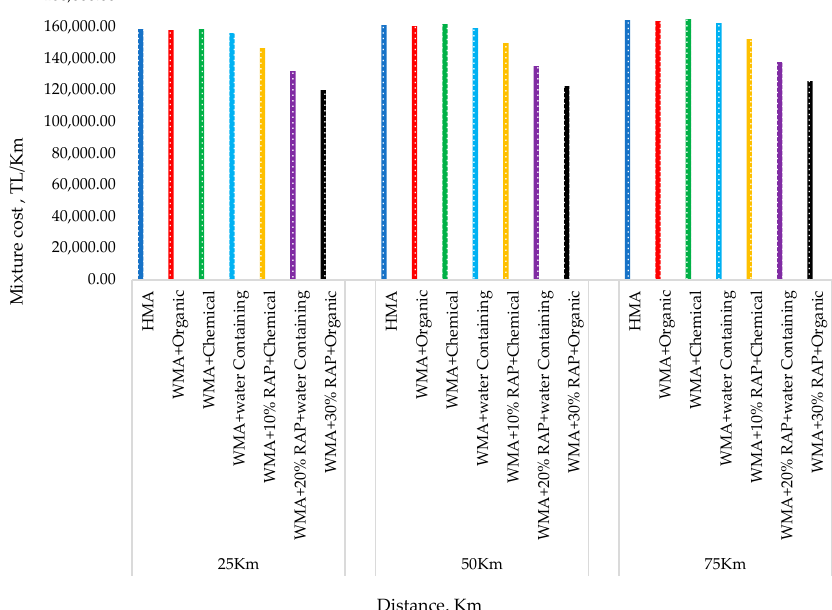
Figure 6. Cost analysis for HMA and WMA with RAP.